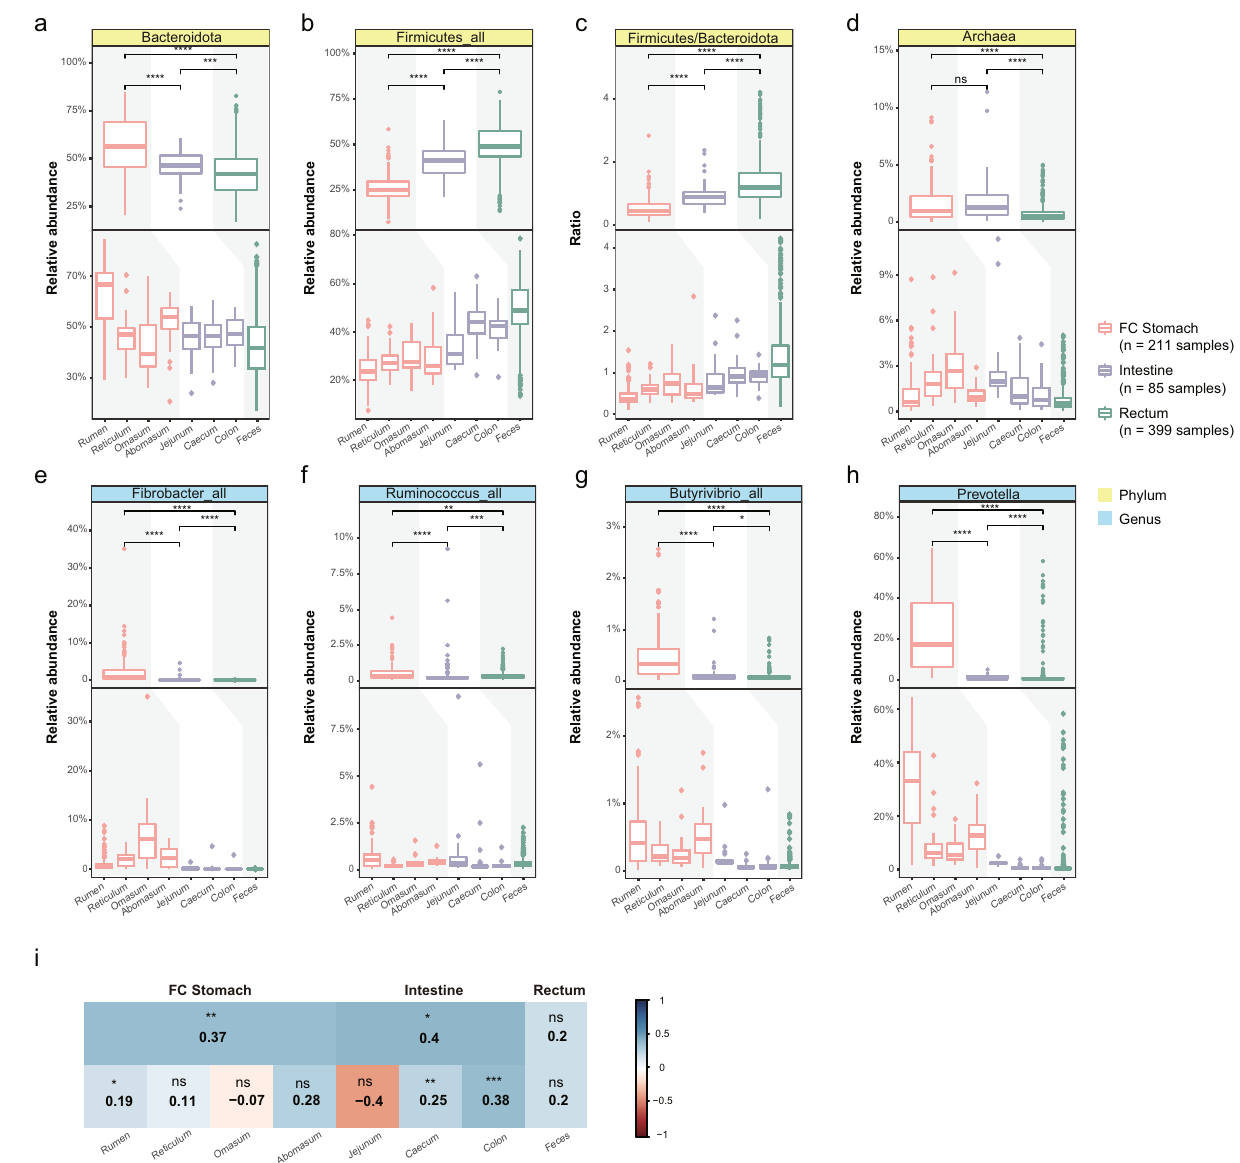
Fig. 4 Distinct abundance patterns of MAGs correlate with the functions of the digestive tract. In panels a – h (except c ), boxplots are used to summarize the abundance distributions of the abundance of taxa of interest in the three sections (upper part) and eight sites (lower part) sampled; the Y -axis in these panels (except c ) indicates the relative abundances, while that in c indicates the abundance ratios between Firmicutes and Bacteroidota. The background colours of the panel labels indicate the classi fi cation levels of microbes, while the different colours of the boxes indicate the different sections of the DT: FC stomach (orange, n = 211 samples), intestine (purple, n = 85 samples), and rectum (green, n = 399 samples). The pairwise Wilcoxon rank-sum test was used to compare the groups (the upper part). Boxplots show the median and the 25th and 75th percentiles, the solid lines indicate the minima and maxima, and the points falling outside of the whiskers of the boxplots represent the outliers. Level of signi fi cance: ns P ≥ 0.05, * P < 0.05, ** P < 0.01, *** P < 0.001, **** P < 0.0001. i Heatmap showing the Spearman correlation between archaea and Fibrobacter_all along the DT; the numbers are the correlation coef fi cients between archaea and Fibrobacter_all . The correlations of all phyla and genera from a – h are shown in Supplementary Fig. 9. The pairwise Wilcoxon rank-sum test was used to compare the groups. Level of signi fi cance: ns P ≥ 0.05, * P < 0.05, ** P < 0.01, *** P < 0.001, **** P <